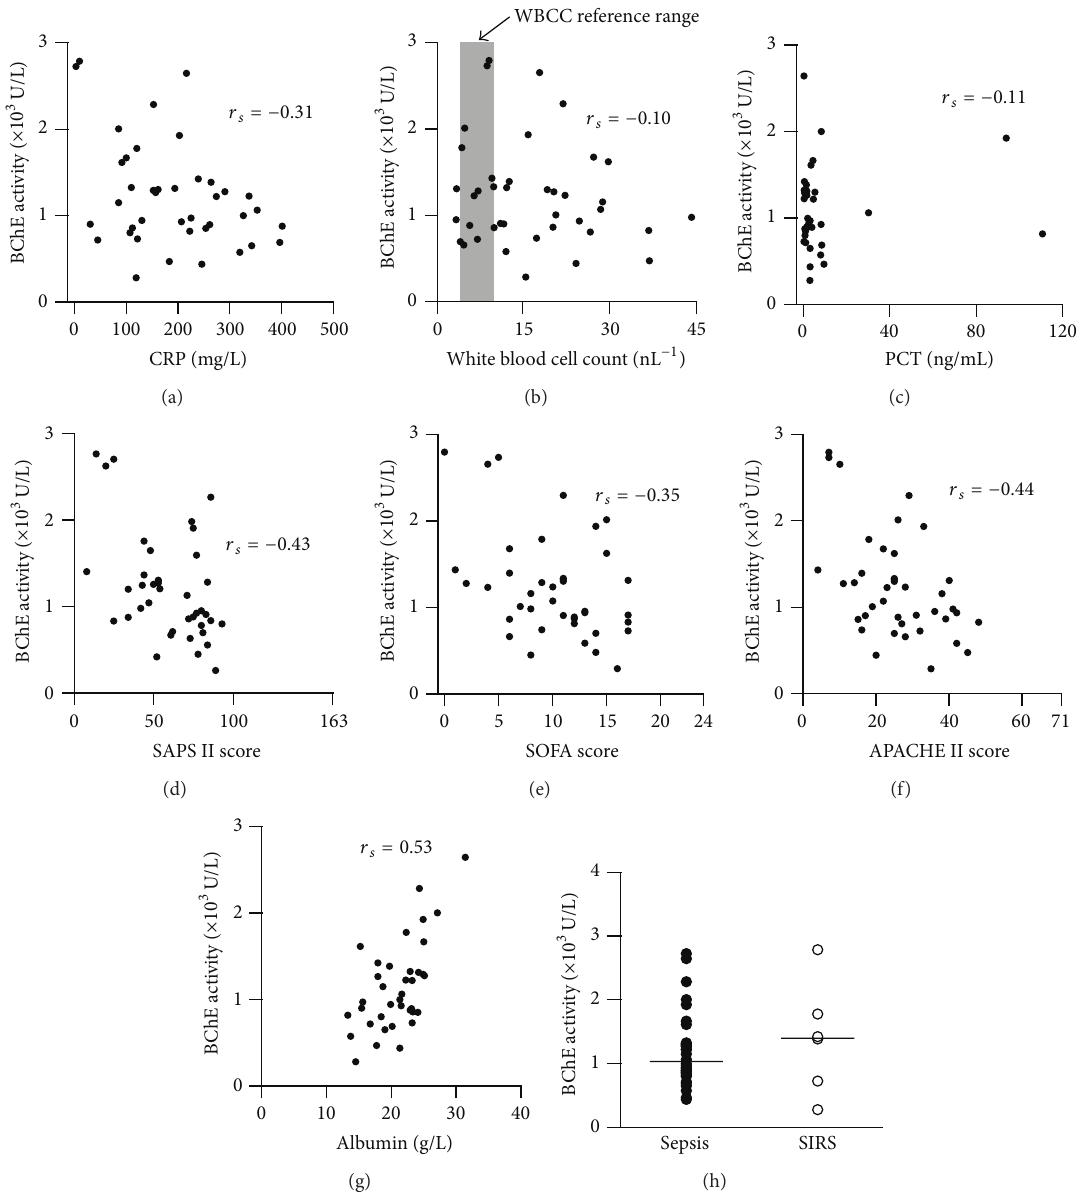
Figure 2: BChE activity correlates with the severity of systemic inflammation. Scatter plots illustrate a correlation between BChE activity and CRP level ( 𝑛 = 40 measurements (a)) and white blood cell count (WBCC, 𝑛 = 40 measurements) (b) measured from patients with systemic inflammation. Shaded box in diagram (b) denotes laboratory reference interval (healthy limits) used for the WBCC. The analysis revealed no correlation between BChE activity and PCT concentration ( 𝑛 = 34 measurements (c)). BChE activity inversely correlates with SAPS II (d), SOFA (e), and APACHE II (f) disease severity scores ( 𝑛 = 40 measurements each). Panel (g) indicates strong direct correlation between serum albumin level, a disease severity biomarker, and BChE activity obtained from patients with severe systemic inflammation ( 𝑛 = 40 measurements). Histogram (h) represents BChE activity measurements from patients with diagnosed sepsis (closed circles) and those with SIRS (inflammation without proven infection, open circles). Bars are median values. 𝑟 𝑠 : Spearman correlation coefficient; SAPS: simplified acute physiology score; SOFA: sequential organ failure assessment; APACHE: acute physiology and chronic health evaluation; SIRS: systemic inflammatory response